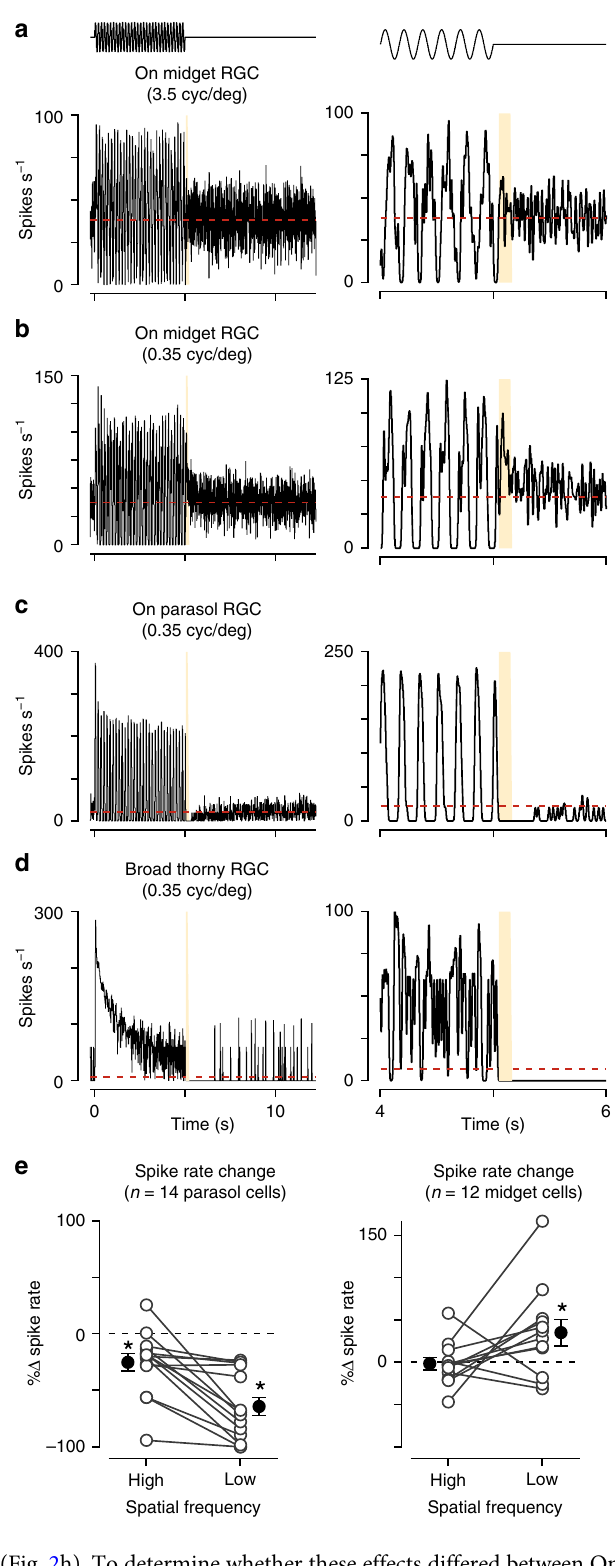
(Fig. 2h). To determine whether these effects differed between On and Off midget cells, we separately analyzed the sensitivity metrics for On and Off cells for this stimulus paradigm. Following the adapting stimulus, contrast sensitivity signi fi cantly increased relative to the unadapted control in both On and Off midget cells at contrasts ≤ 0.25 ( p < 0.05; Wilcoxon signed rank